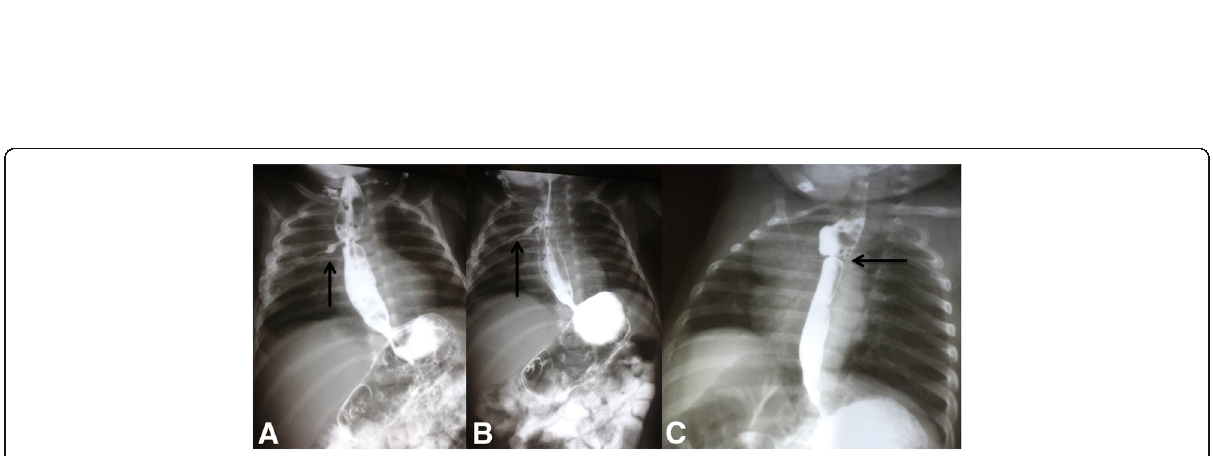
Fig. 5 Esophageal atresia with distal fistula in a neonate. a Plain X-ray shows a distended stomach with gases. b Lateral esophagogram illustrates the proximal esophageal pouch (arrow). c AP esophagogram accidentally detecting the fistula (arrow) with opacification of the distal esophagus (due to spill over of contrast to the trachea to the fistula then to the esophagus)